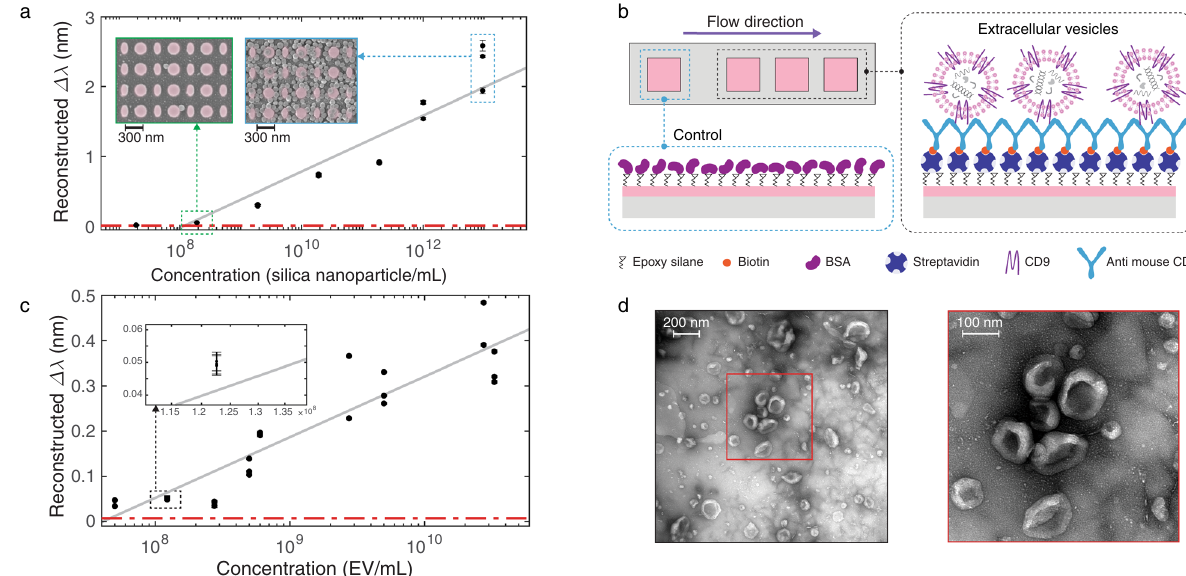
Fig. 4 Biosensing using reconstructed spectral shift based on aided imaging method. a The reconstructed spectral shift ( Δ λ ) calibration curve of biotinylated silica nanoparticles (100 nm diameter). The insets are scanning electron microscopy images of the sensors with bound silica nanoparticles on resonators after introducing suspensions with 1.9× 10 8 nanoparticles/mL and 9.5× 10 12 nanoparticles/mL from left to right, respectively. The represented data points in the calibration curves ( a , c ) are the mean Δ λ over time from each sensor over a time-interval consisting of 81 consecutive images after the analyte binding reaches the equilibrium state, and the error bars indicate the standard deviations. The reconstructed Δ λ data points are obtained from seven dilutions of silica nanoparticle solutions over three independent sensors to achieve 21 data points on the calibration curve. The reconstructed Δ λ data from the detection sensors are corrected to the non-speci fi c bindings on the control sensor. Some data points are overlapped due to the good agreement between the sensor performance. b Biorecognition assay to detect extracellular vesicles (EVs) on the detection sensors and on the control sensor blocked with bovine serum albumin (BSA) to account for non-speci fi c binding is shown on top. c The reconstructed spectral shift calibration curve of EVs. The inset is the same plot with a magni fi ed x -axis to better resolve the small error bars for an exemplary data point. The reconstructed shift data points from the detection sensors are corrected to the non-speci fi c bindings on the control sensor. The represented data points are collected from nine different concentrations of EV solutions diluted from three independent batches measured on eight independent sensors to yield 24 data points on the calibration curve. Some data points are overlapped due to the good agreement between the sensors. d Transmission electron microscopy images of EVs from the cell culture supernatant of 4T1 mouse breast cancer cells can be seen at the bottom; the magni fi cations are ×23,000 and ×30,000 from left to right,